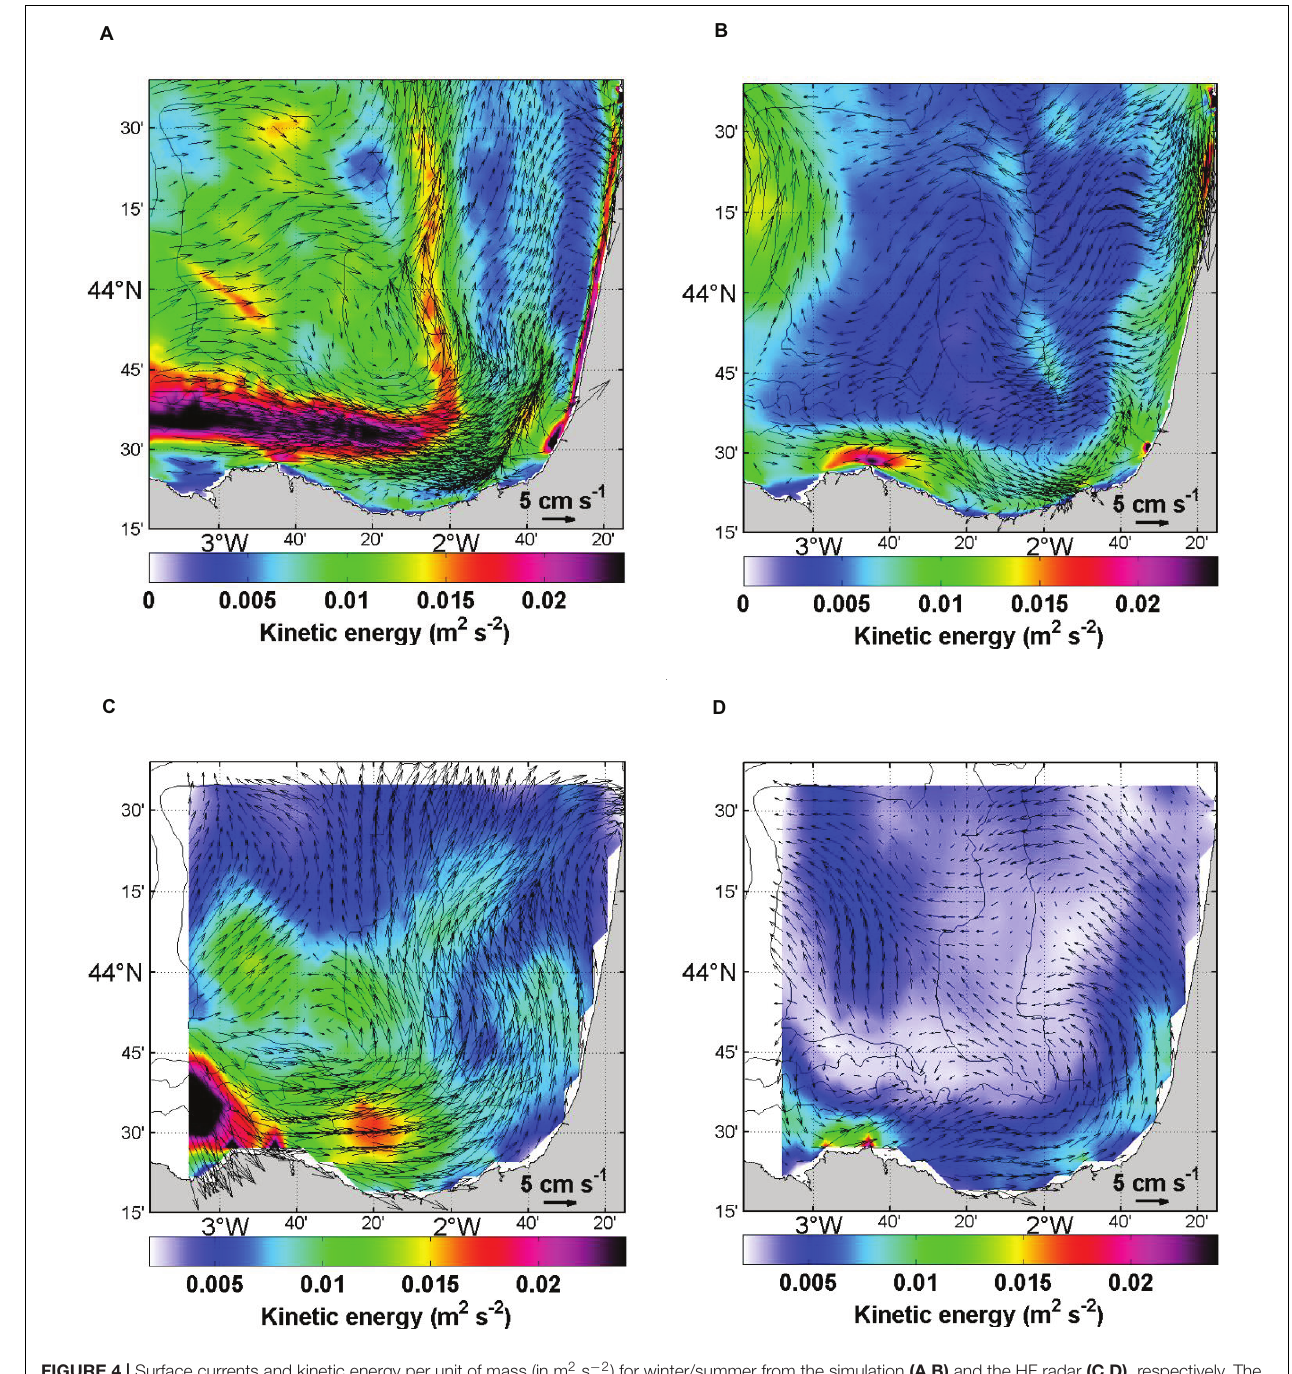
FIGURE 4 | Surface currents and kinetic energy per unit of mass (in m 2 s − 2 ) for winter/summer from the simulation (A,B) and the HF radar (C,D) , respectively. The summer and winter seasons are, respectively defined from May to August and from October to January (to December in 2012 since January 2013 is not available).